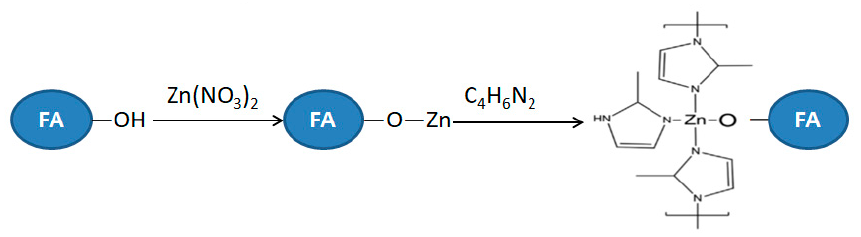
Figure 4. Preparation mechanism of ZIF-8/FA composites.